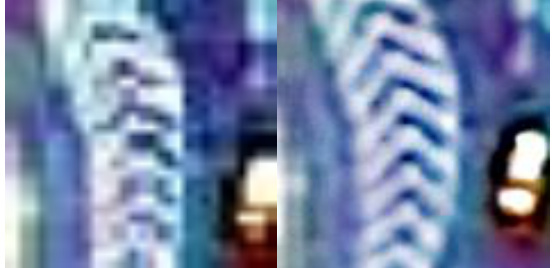
Figure 7. 30*30 LR \ 120*120 SR Road marking in the Worldview-2 satellite image